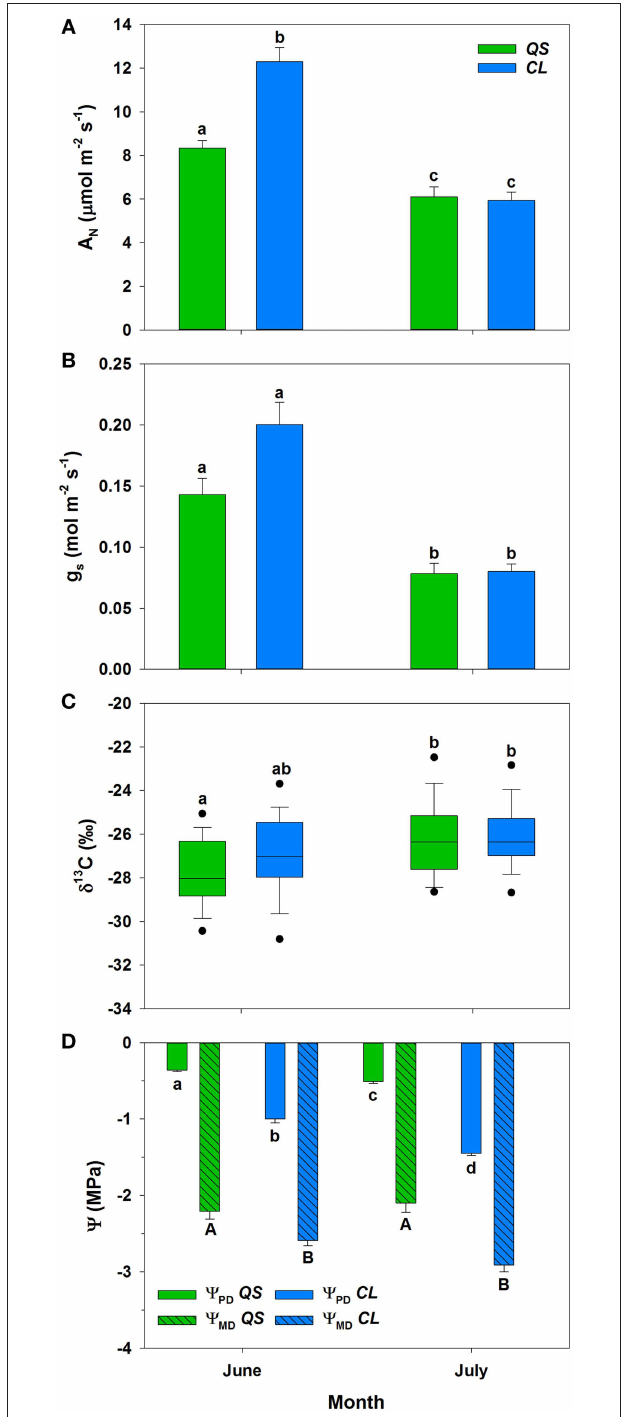
FIGURE 1 | Net assimilation (A N ) (A) , stomatal conductance (g s ) with standard error (B) , and photosynthetic discrimination (C) for Q. suber ( n = 60), and C. ladanifer ( n = 30) with 5 and 95% percentile in June and July. Pre-dawn ( 9 PD ) and midday ( 9 MD ) leaf water potential for Q. suber ( n = 12) and C. ladanifer ( n = 6) with standard error in June and July (D) . Statistical differences (RMANOVA) between species and months are indicated by letters over bars at a significance level of p <